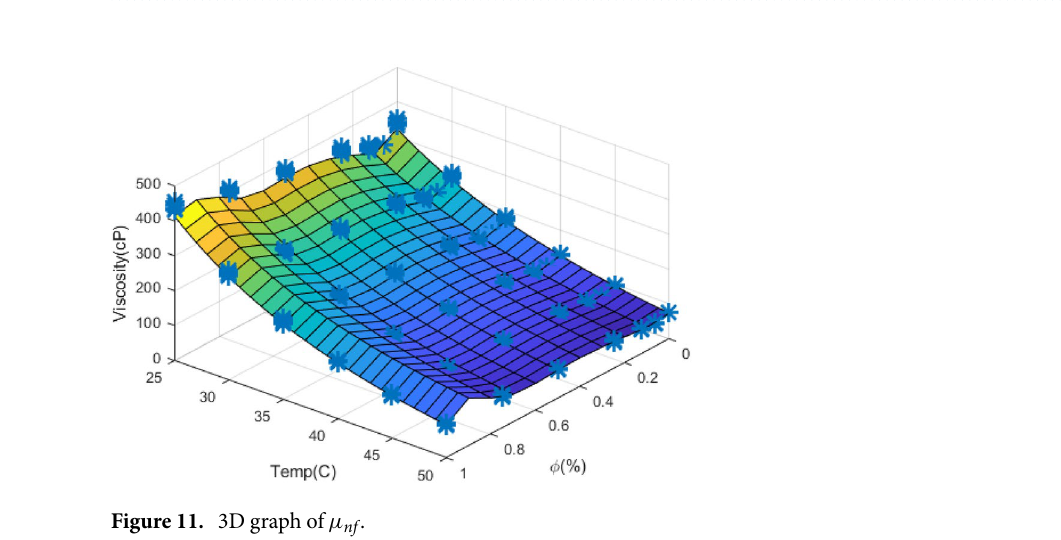
Figure 10. Comparison of ANN outputs and target values for µ nf .